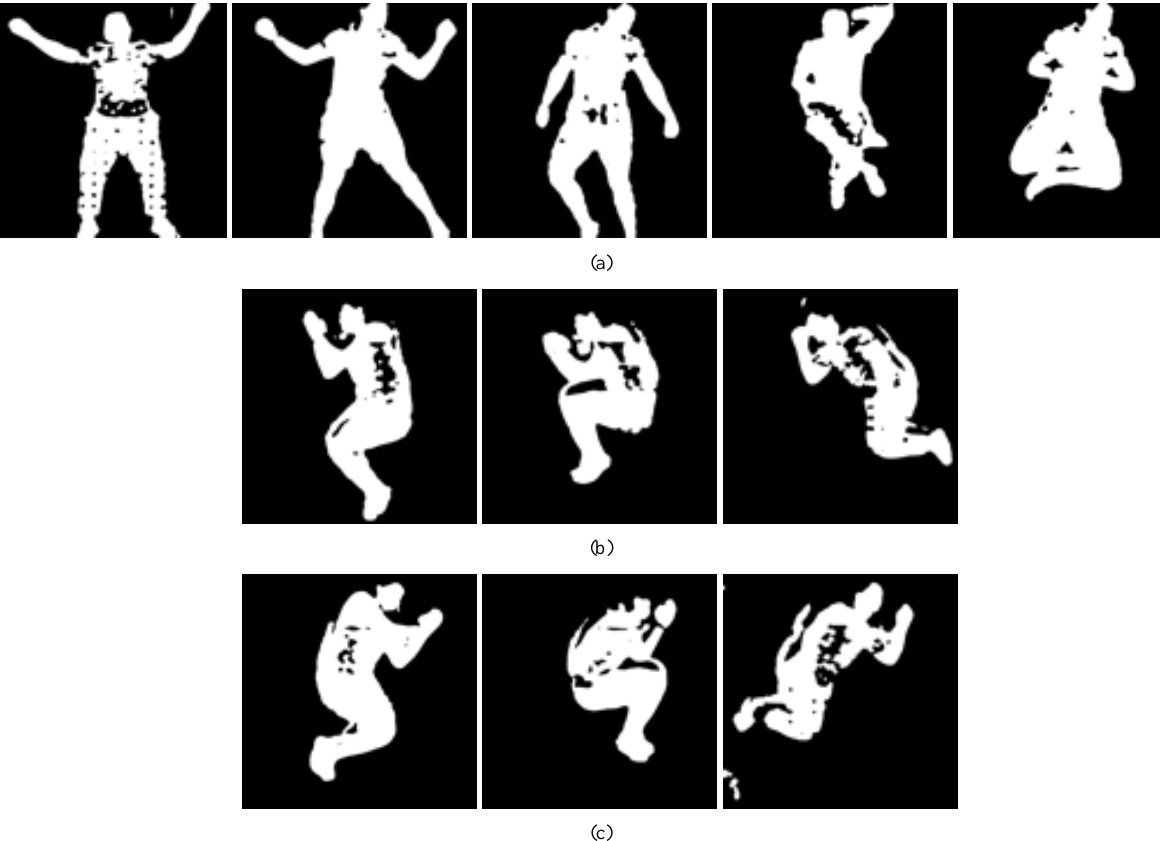
Figure 3. Several samples of training and testing data from the dataset are presented. (a) Threshold images of Supine position, (b) Threshold images of Left position, and (c) Threshold images of Right